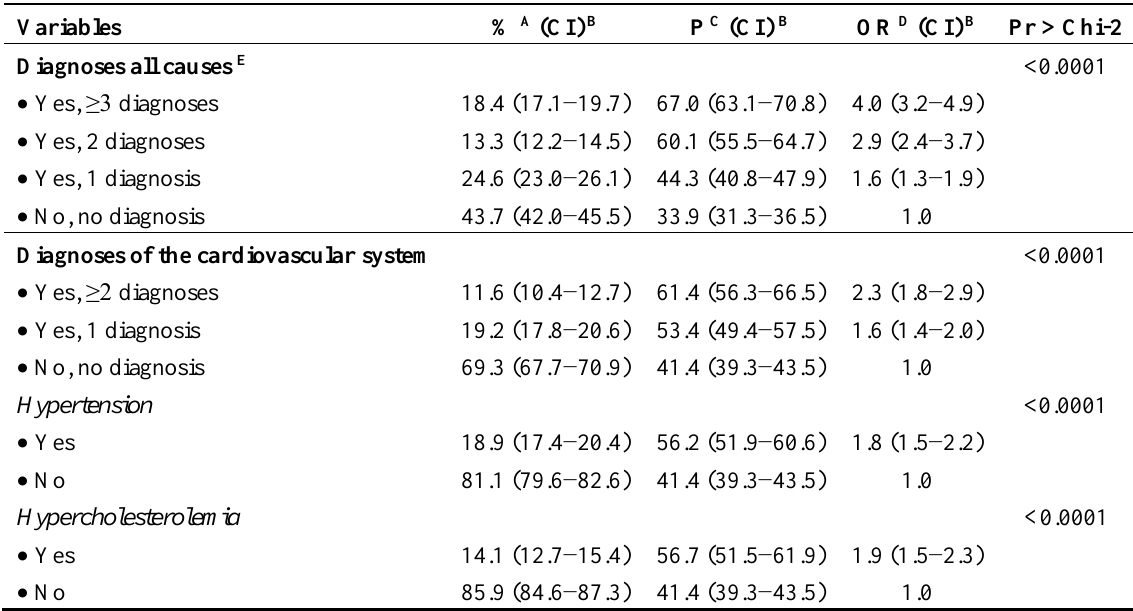
Table 4. Prevalence of reported adverse health impacts, very hot and humid summer conditions, based on diagnoses of chronic